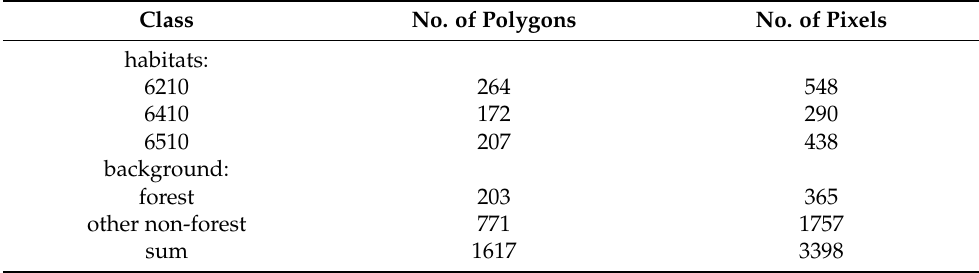
Table 1. Number of reference polygons and pixels used for